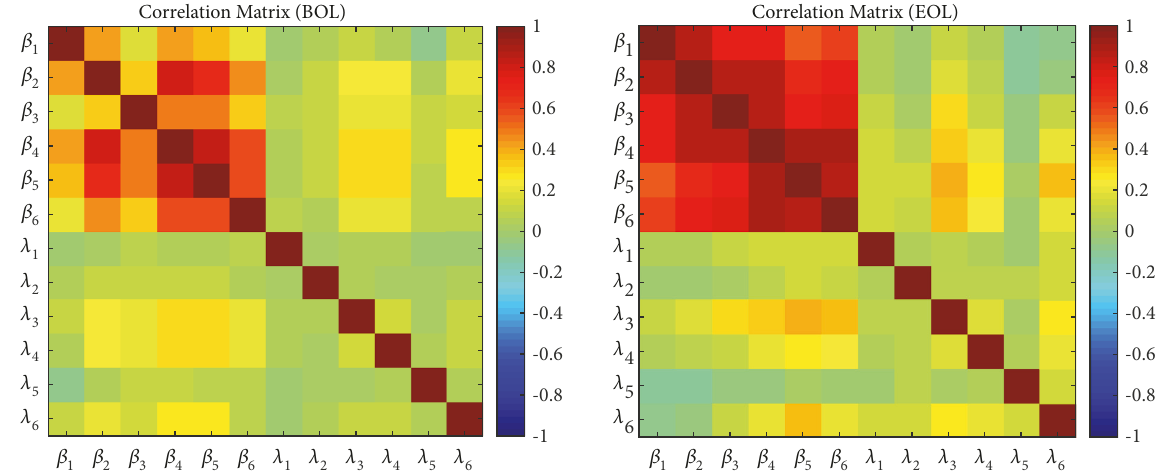
Figure 8: Correlation matrix of the kinetic parameters for the PWR lattice at BOL and